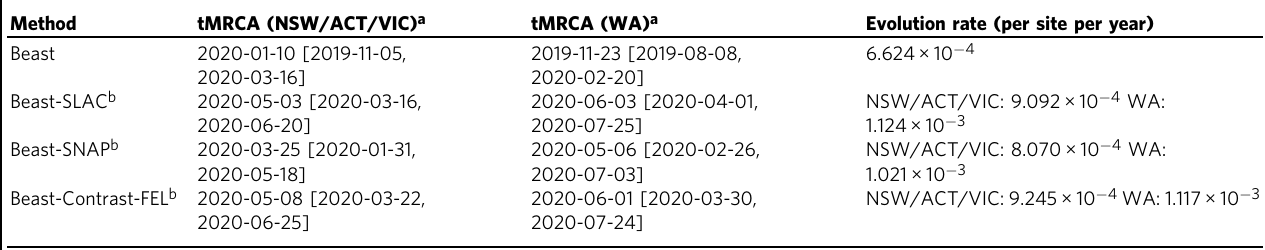
Table 1 Mean time of most recent common ancestors (tMRCA) for NSW/ACT/VIC 2020 and WA 2020 clades estimated by different